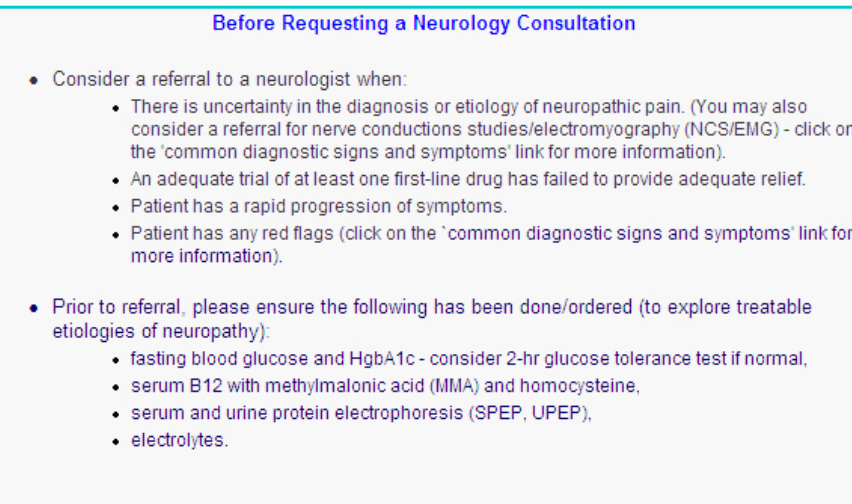
Figure 4. An example "hover box" linked to the box labeled "Before Requesting a Neurology